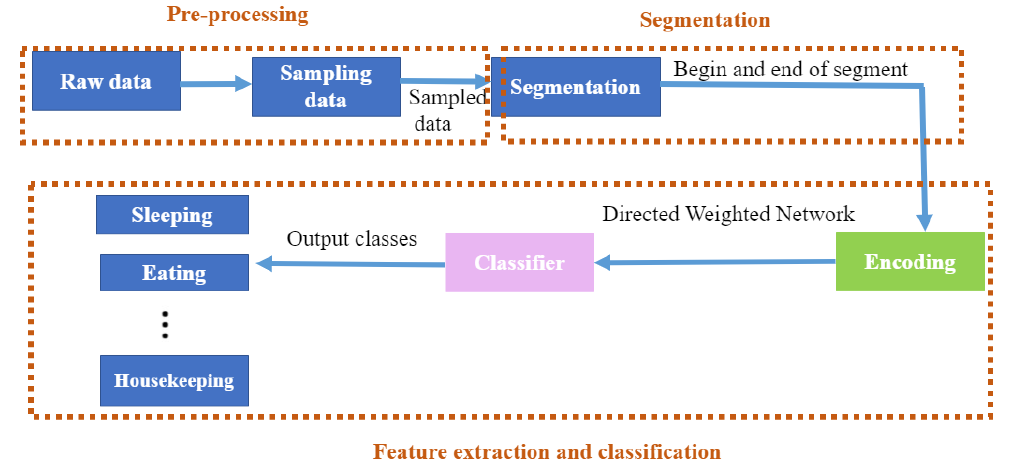
Figure 1. Real-time human activity recognition